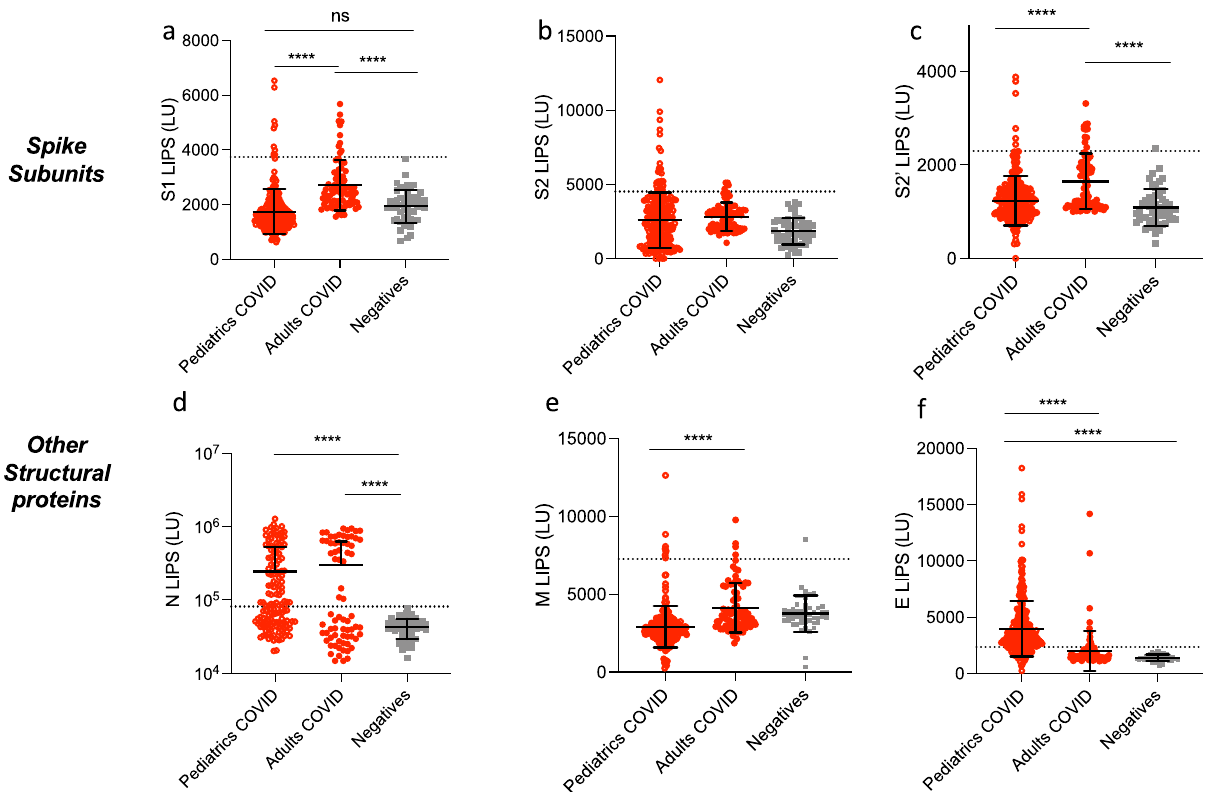
Fig. 1 Comparison of antibody responses to SARS-CoV-2 structural proteins in children and in adults with COVID-19. Antibodies against the SARS- CoV-2 structural proteins Spike S1 subunit (S1) ( a ), Spike S2 subunit ( b ), Spike S2 ′ subunit ( c ), Nucleocapsid (N) ( d ), Membrane (M) ( e ), and Envelope (E) ( f ) were measured by LIPS from samples from pediatrics COVID-19 ( n = 254) or adult patients ( n = 71), and negative controls ( n = 48). Background no plasma values were subtracted. Experiments were repeated twice. The cutoff value is shown by the dotted line and was based on the mean plus 3 × s.d. of the negative control group. All data represent individual time point IgG responses and to a lesser extent IgA and IgM based on protein A/G bead binding by LIPS and the mean ± stdev. Two-sided P values were calculated using the Mann – Whitney U test. * shows statistical signi fi cance between COVID-19 patients versus negative controls. ** p < 0.01, *** p < 0.001, **** p < 0.0001. Signi fi cant p values for pediatrics versus adults are S1 ( a ) p < 0.0001, S2 ′ ( c ) p < 0.0001, M ( e ) p < 0.0001, E ( f ) p < 0.0001. Signi fi cant p values for pediatrics versus negatives are N ( d ) p < 0.0001, M ( e ) p = 0.0008, E ( f ) p <